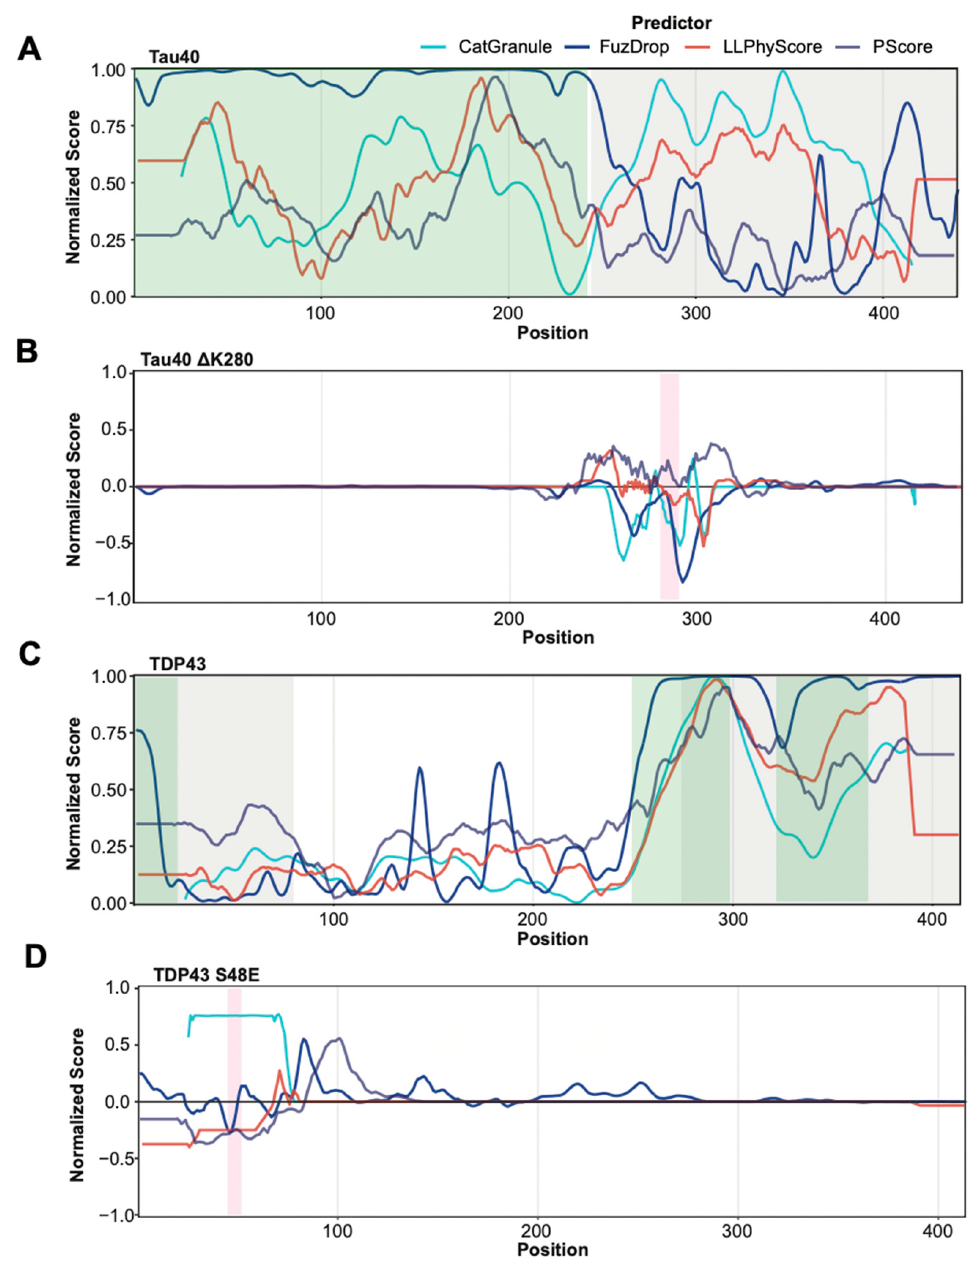
Figure 4. Prediction profiles of selected proteins and mutants. ( A , C ) Normalized prediction scores for Tau40 ( A ) and TDP43 ( C ) provided by catGranule, FuzDrop, PScore and LLPhyScore (colour legend on top). Protein segments that have been experimentally identified as being involved in phase separation are highlighted in grey. Protein segments predicted by IUPred2 as disordered are highlighted in green. ( B , D ) Normalized delta scores (difference between scores of mutant and wild type sequences) for Tau40 ( B ) and TDP43 ( D ) mutants provided by catGranule, FuzDrop, PScore and LLPhyScore. Mutated residue areas are highlighted in magenta. ( B ) Removal of lysine 280 in Tau40 induces a higher propensity to form beta strands, thus driving oligomerization and phase separation [61]. Most tested methods predict the opposite. ( D ) The S48E mutation in TDP43 abolishes phase separation by blocking the TDP43 dimerization interface [62], which is correctly predicted by most tested methods. Of note, this mutation is in a region not predicted to be involved in phase separation by the tested methods (see ( C )).